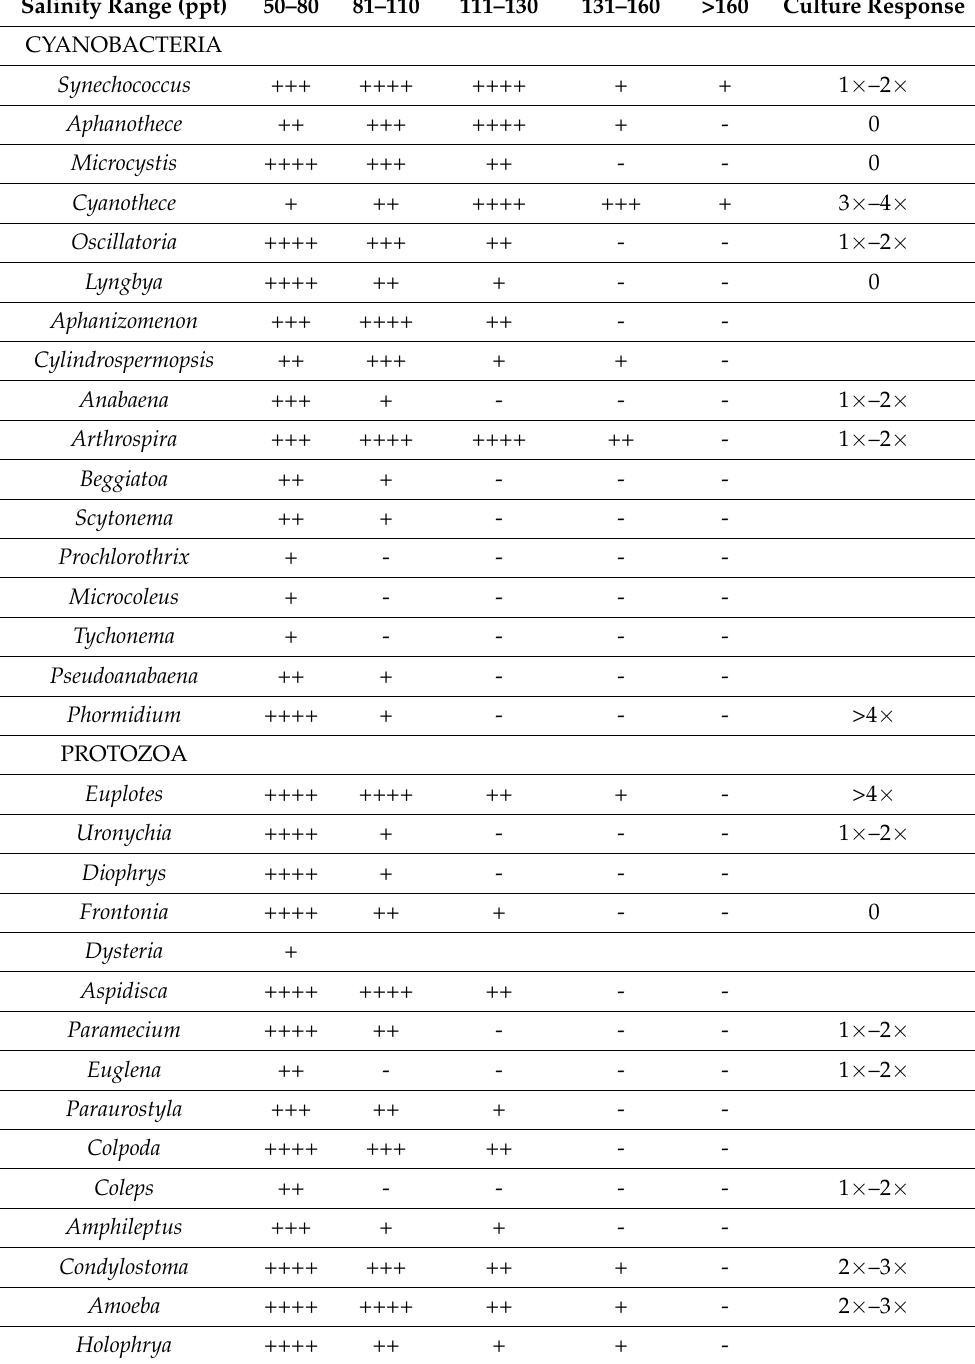
Table 1. The organisms recorded in hypersalinity at Messolonghi saltworks identified to the genus level. “+” stands for the least presence, “++++” for maximum and “-“ for absence in relation to the counts sum of each particular organism across salinities (absolute abundance) and in combination with a rather rough estimation of their relative abundance among all other organisms in each particular sample examined. Concerning their response to the culture trials, notations in the column “Culture Response” mean: “0” = no change or decrease in the initial number of organisms, “1 × –2 × “ = increase of 1–2 times in the initial number of organisms, “2 × –3 × ”, = increase of 2–3 times, “3 × –4 × ” = increase of 3–4 times, “>4 × ” = increase of over 4 times. Detailed records in the Supplementary Material of Table